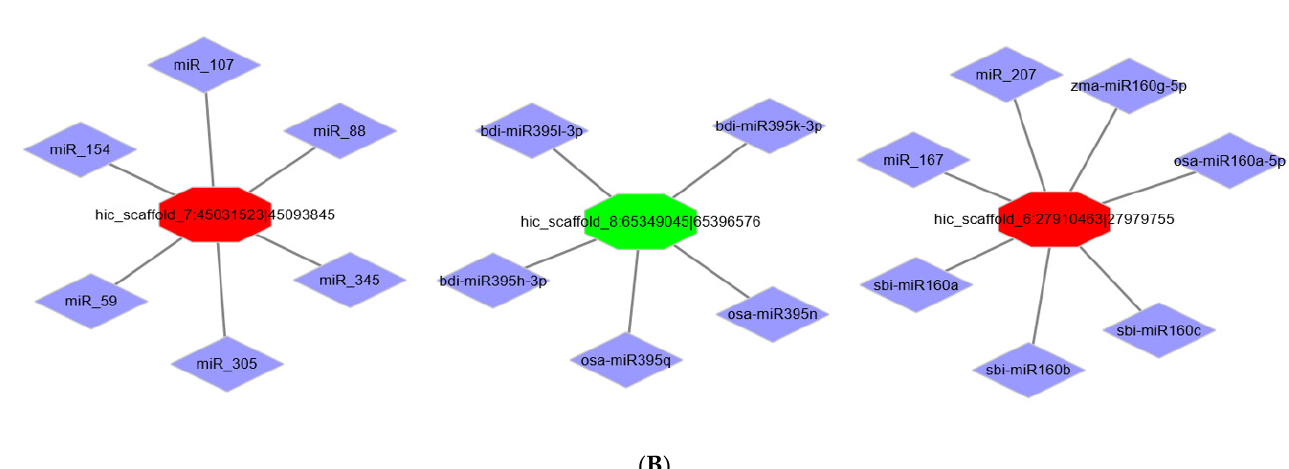
Figure 6. The DEcircRNAs-miRNA interaction network. ( A ) Different DEcircRNAs share a common miRNA. ( B ) Different DEcircRNAs share different miRNAs. Blue nodes: miRNAs. Red nodes: Up-regulated circRNAs. Green nodes: Down-regulated circRNAs.